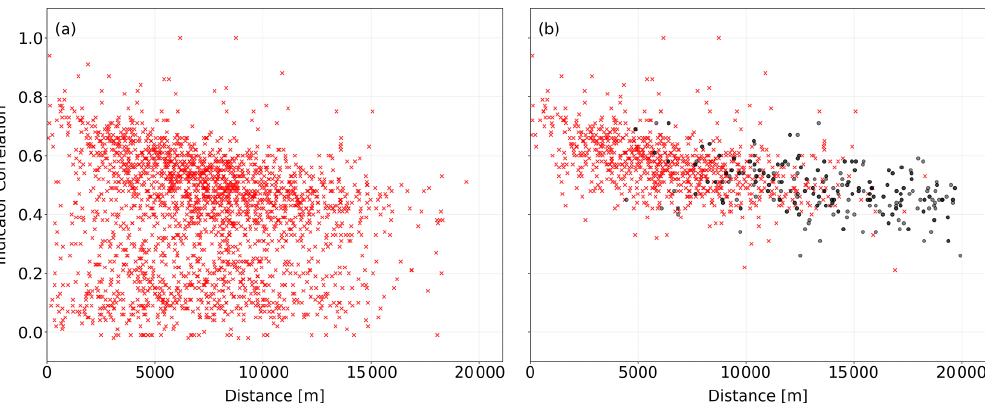
Figure 6. Indicator correlations for 1h temporal resolution and α = 0 . 99 between the secondary network and the nearest primary network stations before (a) and after (b) , applying the IBF (red crosses). The black dots refer to the indicator correlation between the primary network